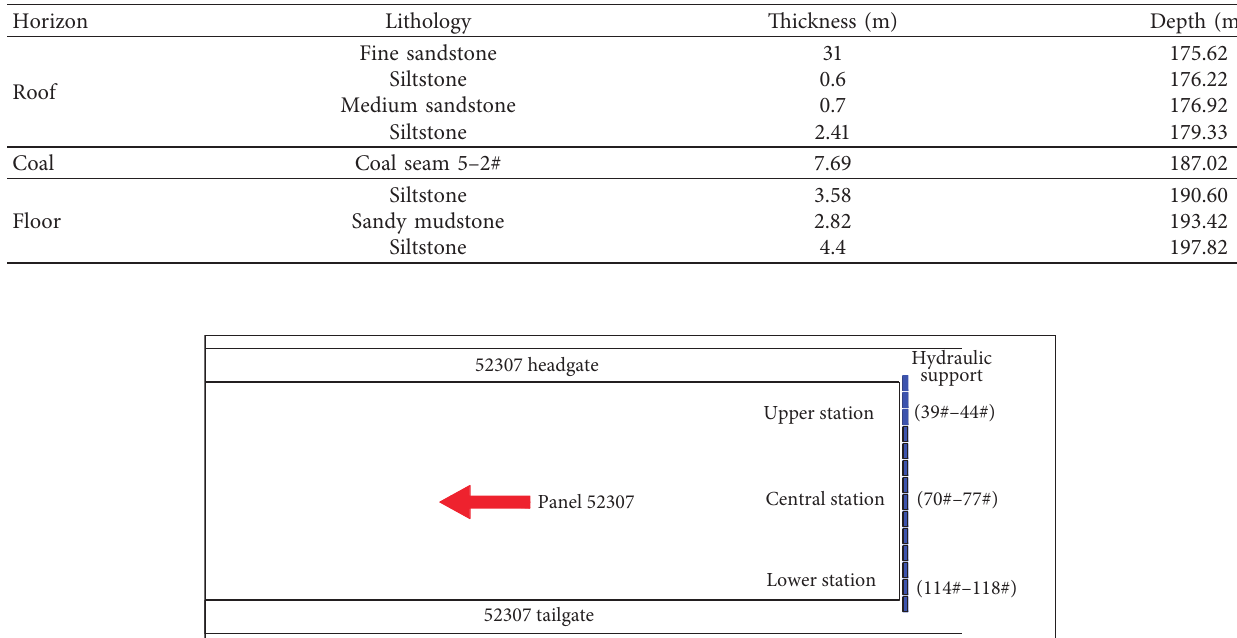
Table 1: Partial table of strata parameters.